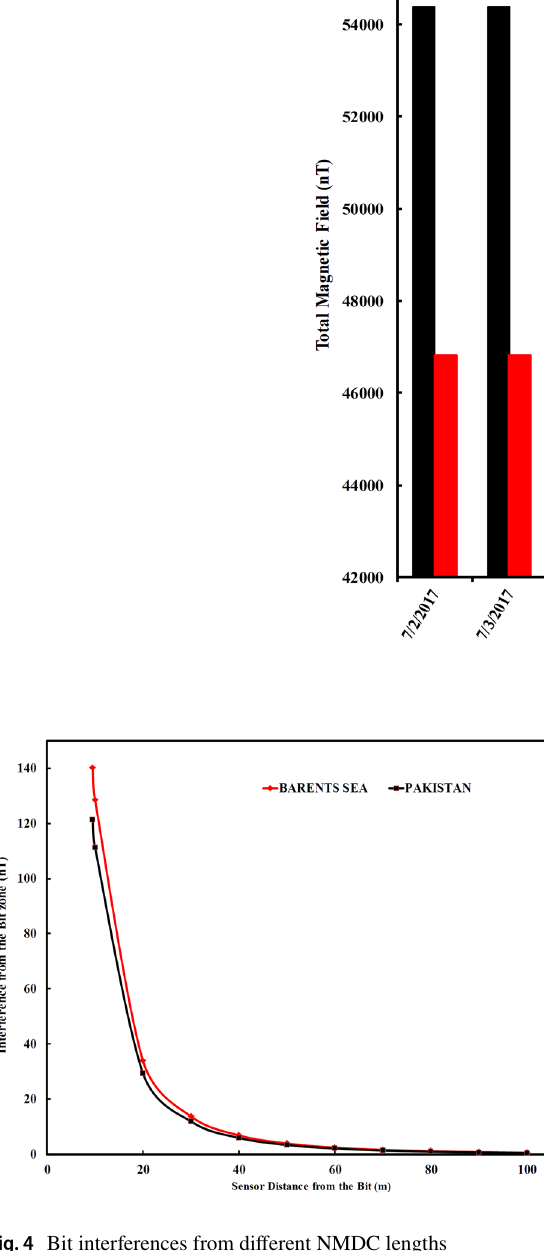
Fig. 3 Total magnetic field comparison between a region in Pakistan and Barents Sea